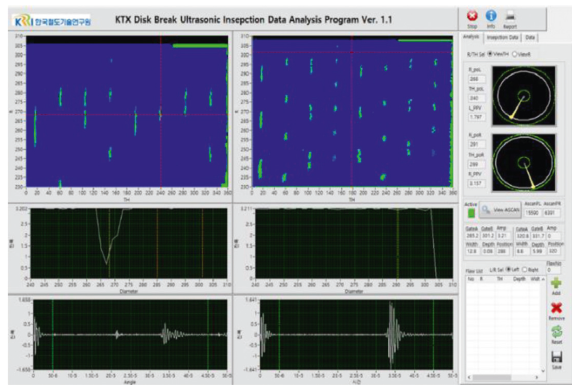
Figure 11: The interface of software for crack analysis.